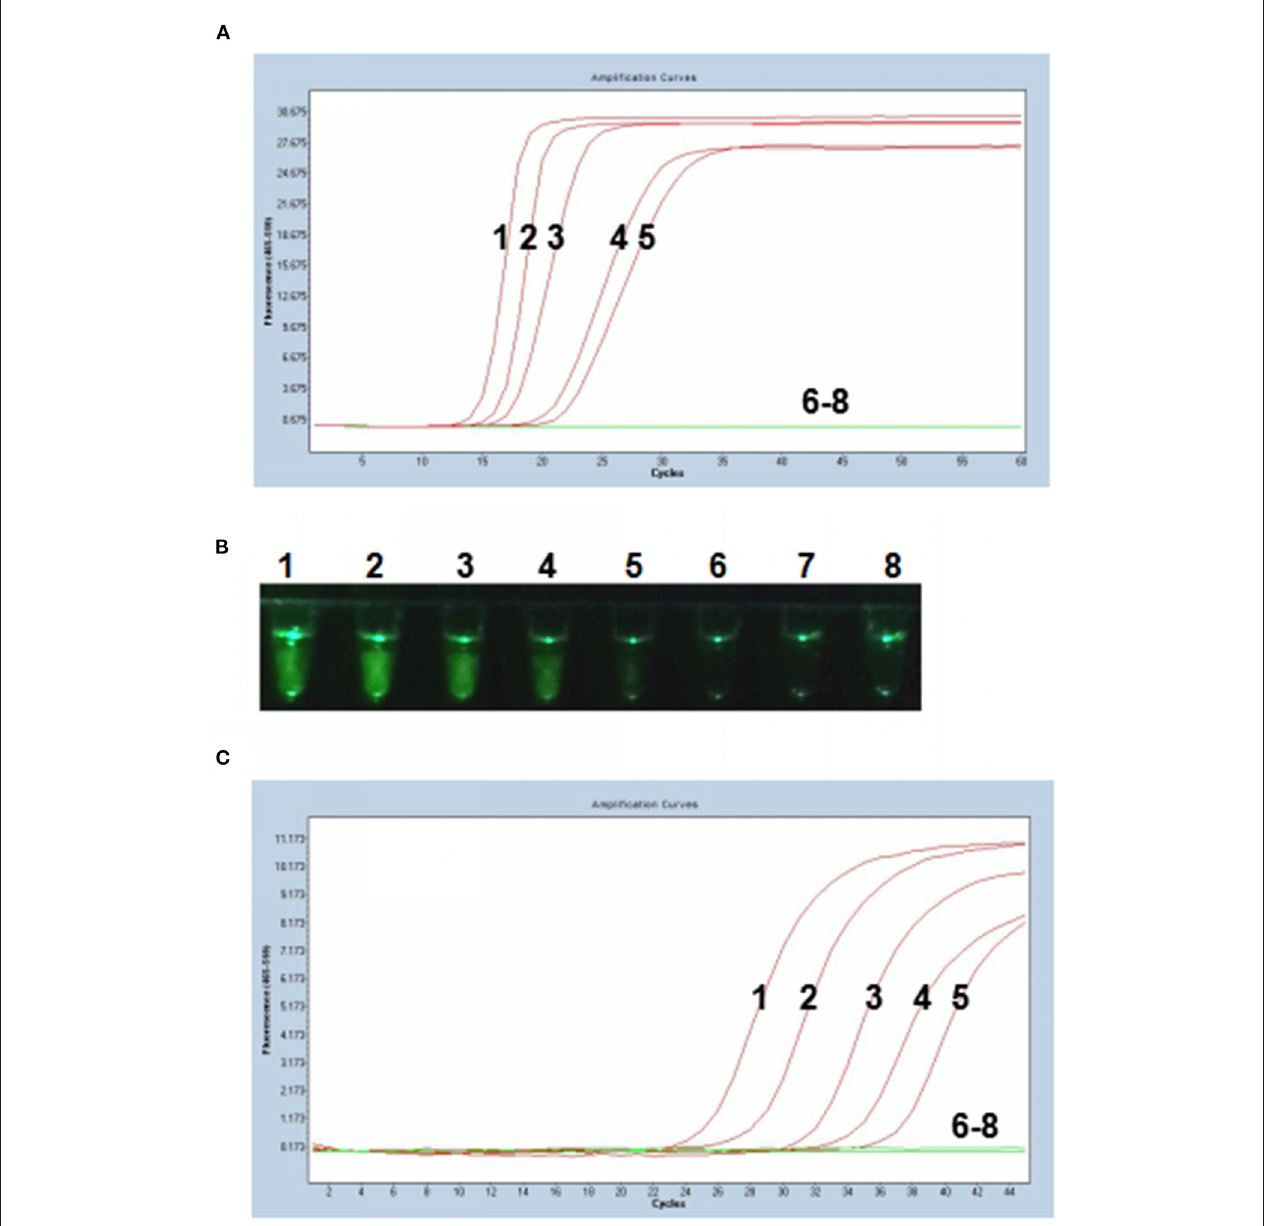
FIGURE 3 | Comparison of sensitivity of the P-S-MCDA and qPCR. (A) Sensitivity of P-S-MCDA by the Roche Light Cycler 480 II. (B) Sensitivity of P-S-MCDA using a smartphone-based cassette. (C) Sensitivity of qPCR by the Roche Light Cycler 480 II. Lanes or Tubes 1–7, DNA of pMD19T-capsid plasmid (10 5 , 10 4 , 10 3 , 10 2 , 10 1 , 10 0 , and 10 − 1 copies). Lane or Tube 8, ddH 2